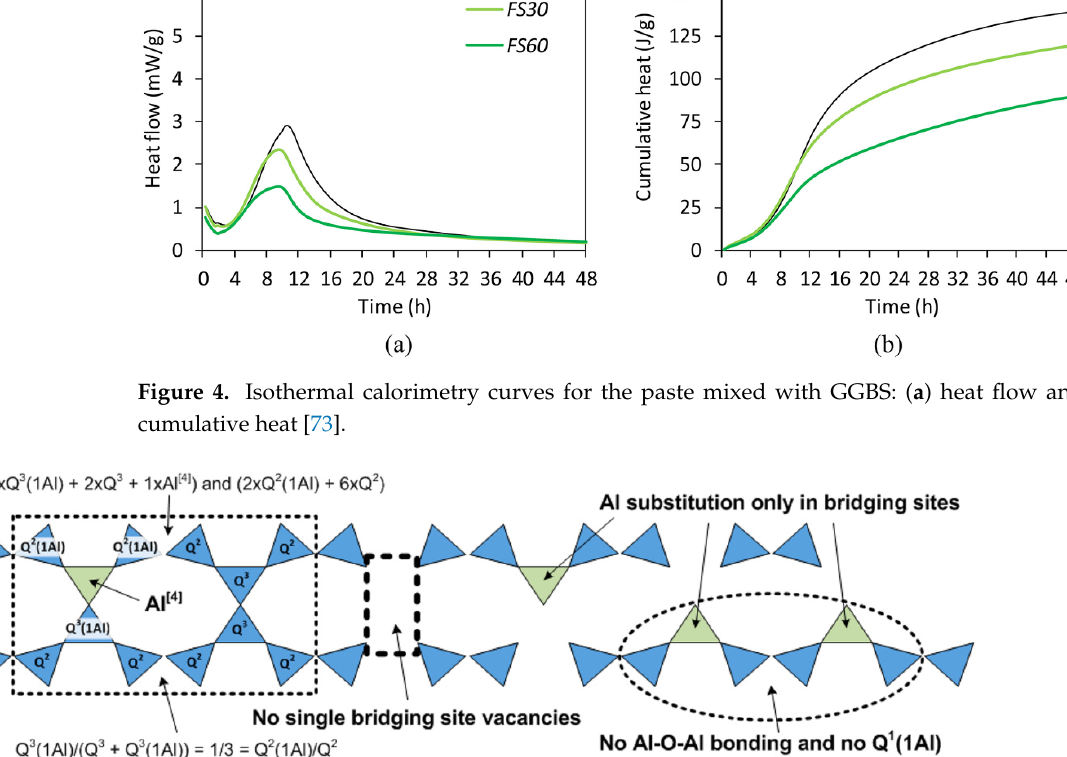
Figure 5. The cross-linked and non-cross-linked structures of the C-(N)-A-S-H type gel [72].